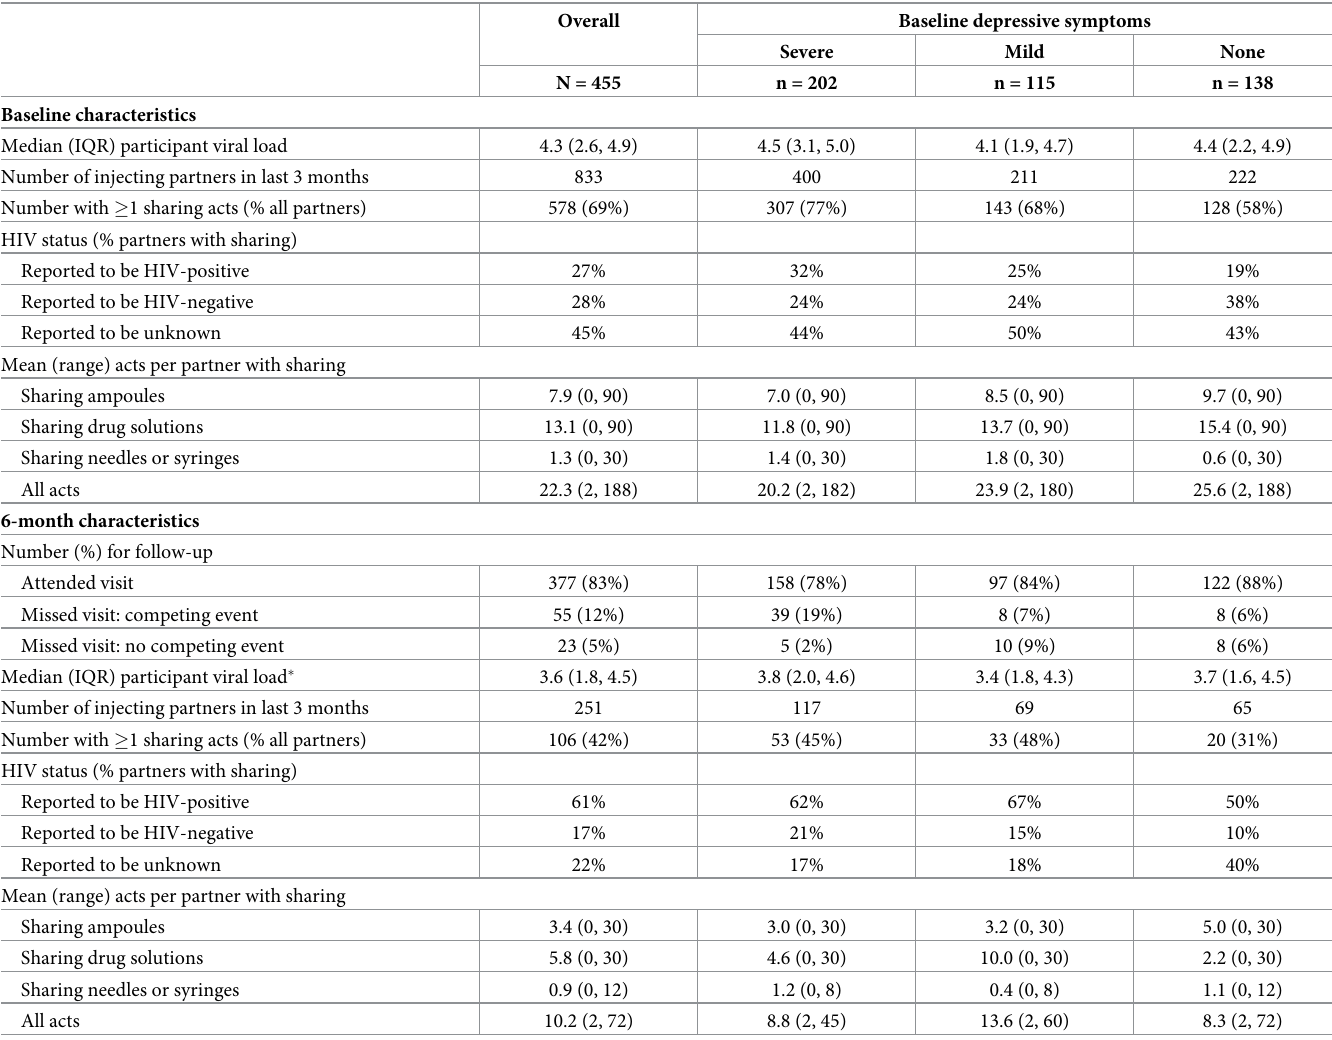
Table 1. Transmission-related characteristics of study